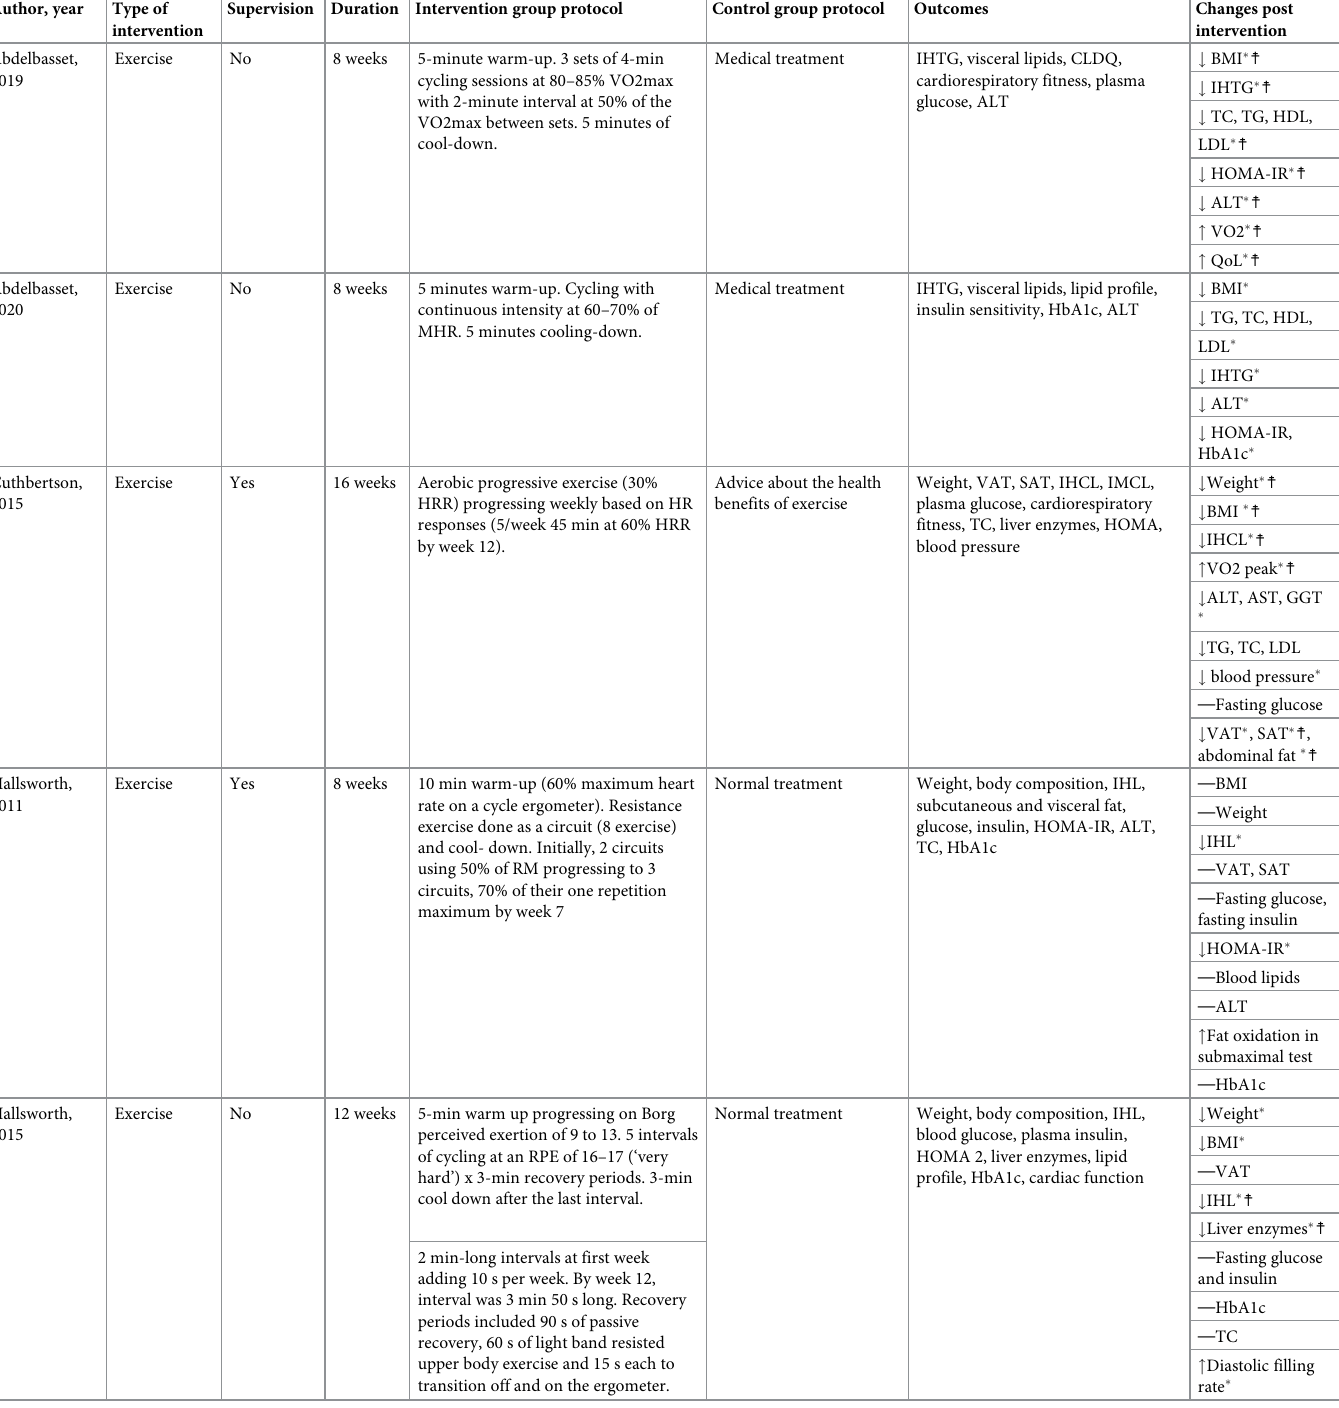
Table 2. Trials evaluating exercise alone in NAFLD